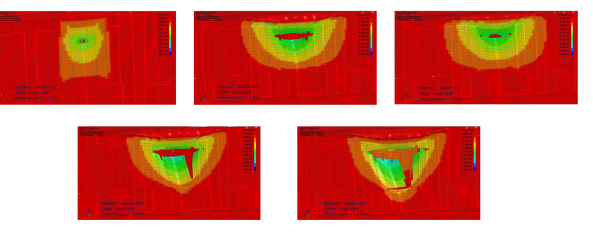
Figure 9: Summary of dynamic displacement behavior of the single side skin [SSS]